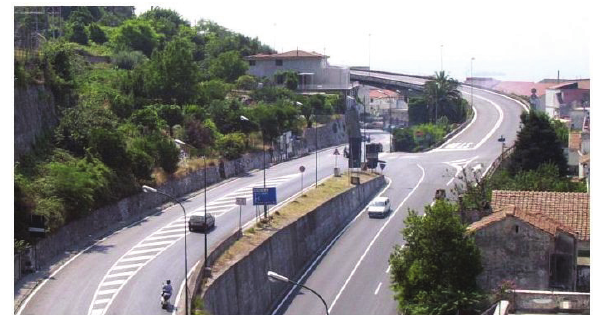
Fig. 1. The intersection subject of the study